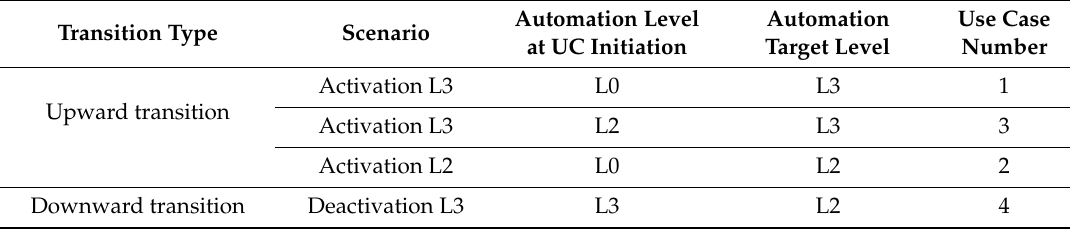
Table 3. Overview of use cases for one experimental